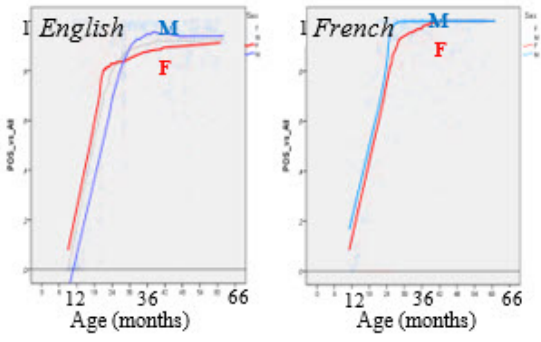
Figure 1. Utterances with phonologi- cal content recognizable as word-forms in the given language. Ratio over all utterances.